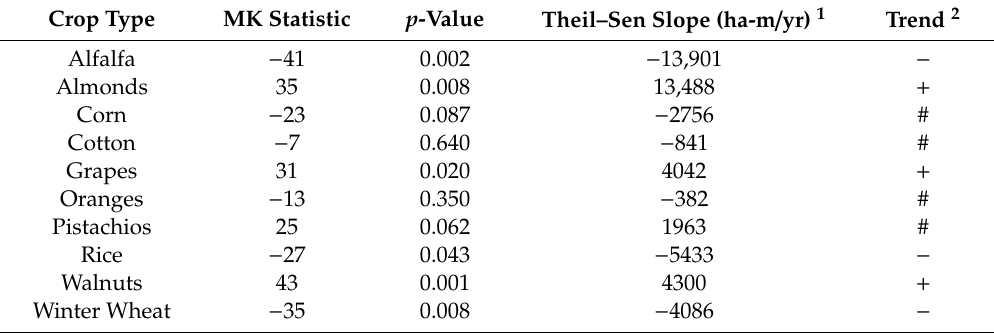
Table 5. Simple Mann–Kendall trend test results for CDL crop water use by volume in the Central Valley from 2008 to 2018 for the top 10 major crops showing: (1) Mann–Kendall trend statistic, (2) p -value, (3) Theil–Sen slope (ha-m / yr) from 2008 to 2018, and (4) the significant trend where ( + ) and ( − ) indicate statistically significant increasing or decreasing trends, respectively, where the p -value is less than 0.05 and (#) signifies the trend is not statistically significant and the p -value is greater than